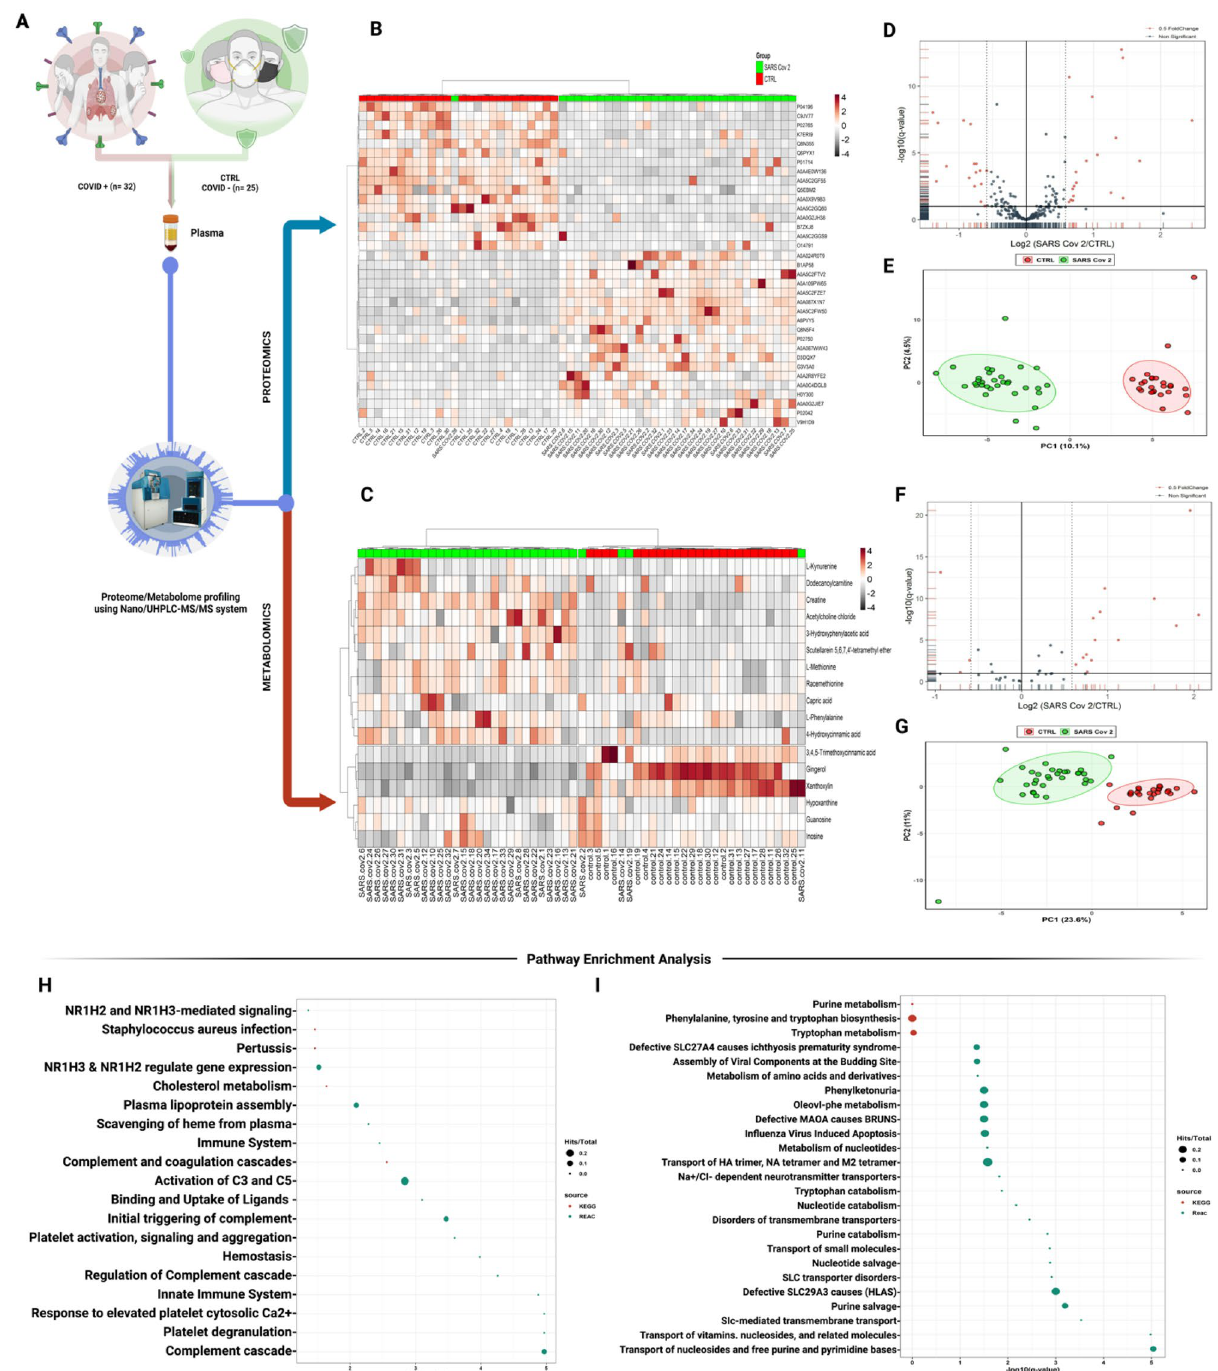
Figure 1. Proteomic and metabolomic analysis of plasma from COVID-19 patients. ( A ) Holistic view of the experimental design starts with plasma extraction from 57 individuals: 25 healthy individuals and 32 severely diagnosed SARS-CoV-2-positive patients. ( B , C ) Heat map hierarchical clustering highlights the top 25 significant proteins and metabolites between the two groups, respectively. ( D , F ) Volcano plot analysis showing DEPs and DEMs, respectively ( E , G ) Principle component analysis for proteomics and metabolomics profiles, respectively. ( H , I ) pathway enrichment analysis of untargeted proteomics ( H ) and metabolomics ( I ) retrieved from KEGG and Reactome databases using proteins and metabolites passed FDR 5% (q-value) and p value < 0.05. Colours represent different databases. The size of the circle reflects the identified number of hits over the total pathway entities. The x-axis represents the –log10 of the